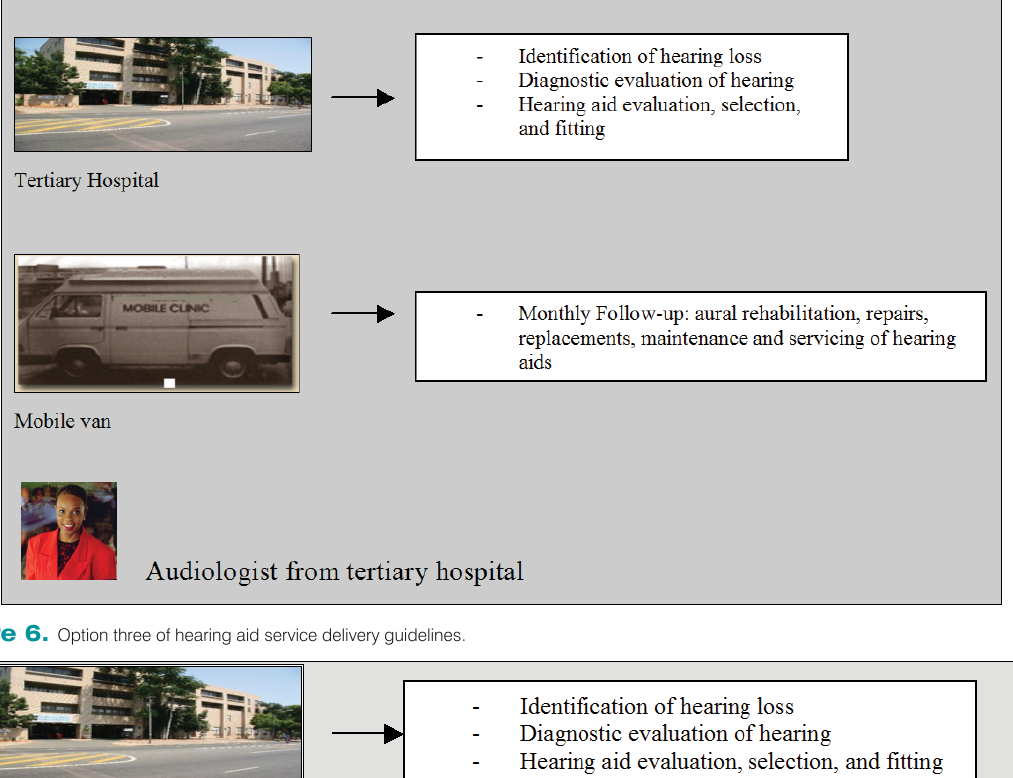
Figure 5. Option two of hearing aid service delivery guidelines.